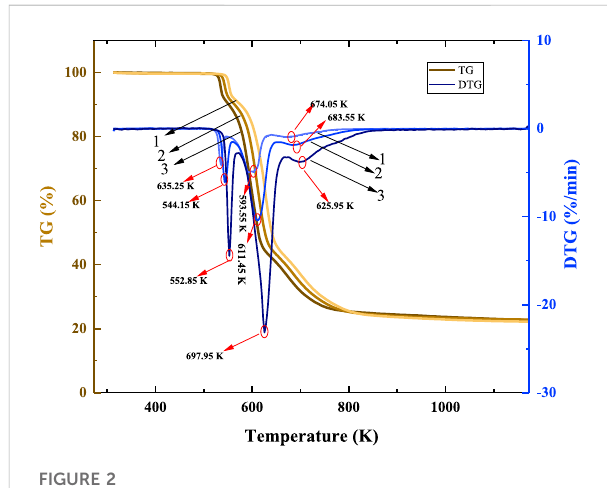
FIGURE 2 Galanthamine hydrobromide TG-DTG curves under